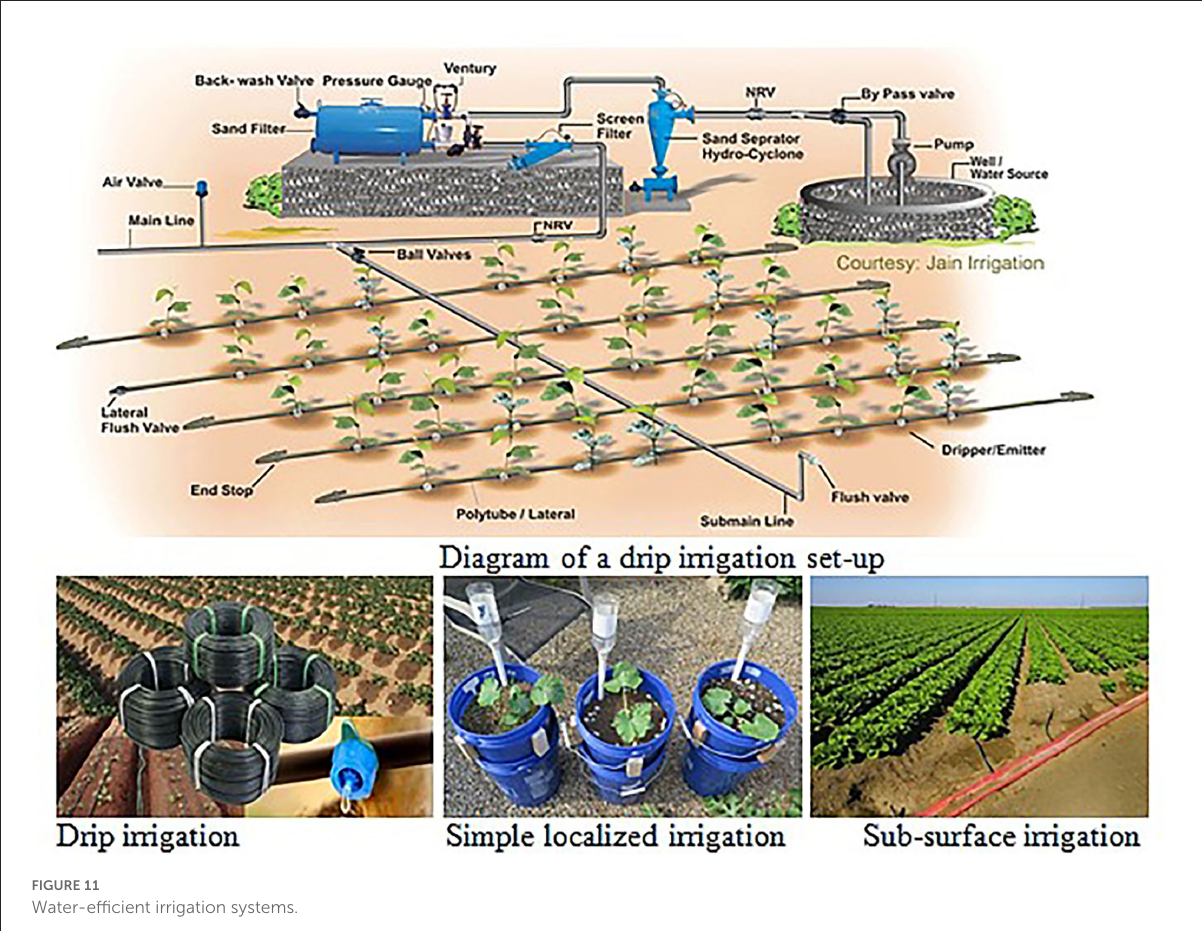
FIGURE11 Water-efficient irrigation systems.